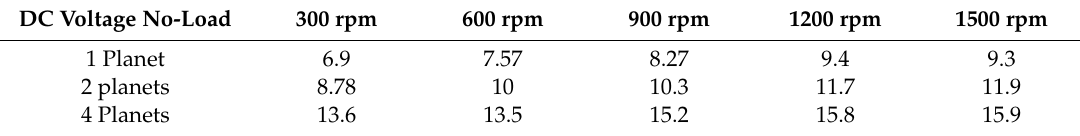
Table 1. DC Voltage Amounts for the Di ff erent Speeds Measured with No Load. DC Voltage